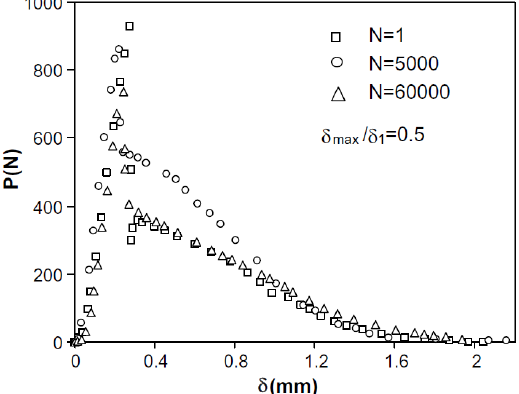
Figure 37. Pull-out load-displacement curve with increasing number of cycles (CFRP z-Pins, 4 × 4 array, d = 0.51 mm, [0 / 90] pre-preg, t = 3 mm) [36].